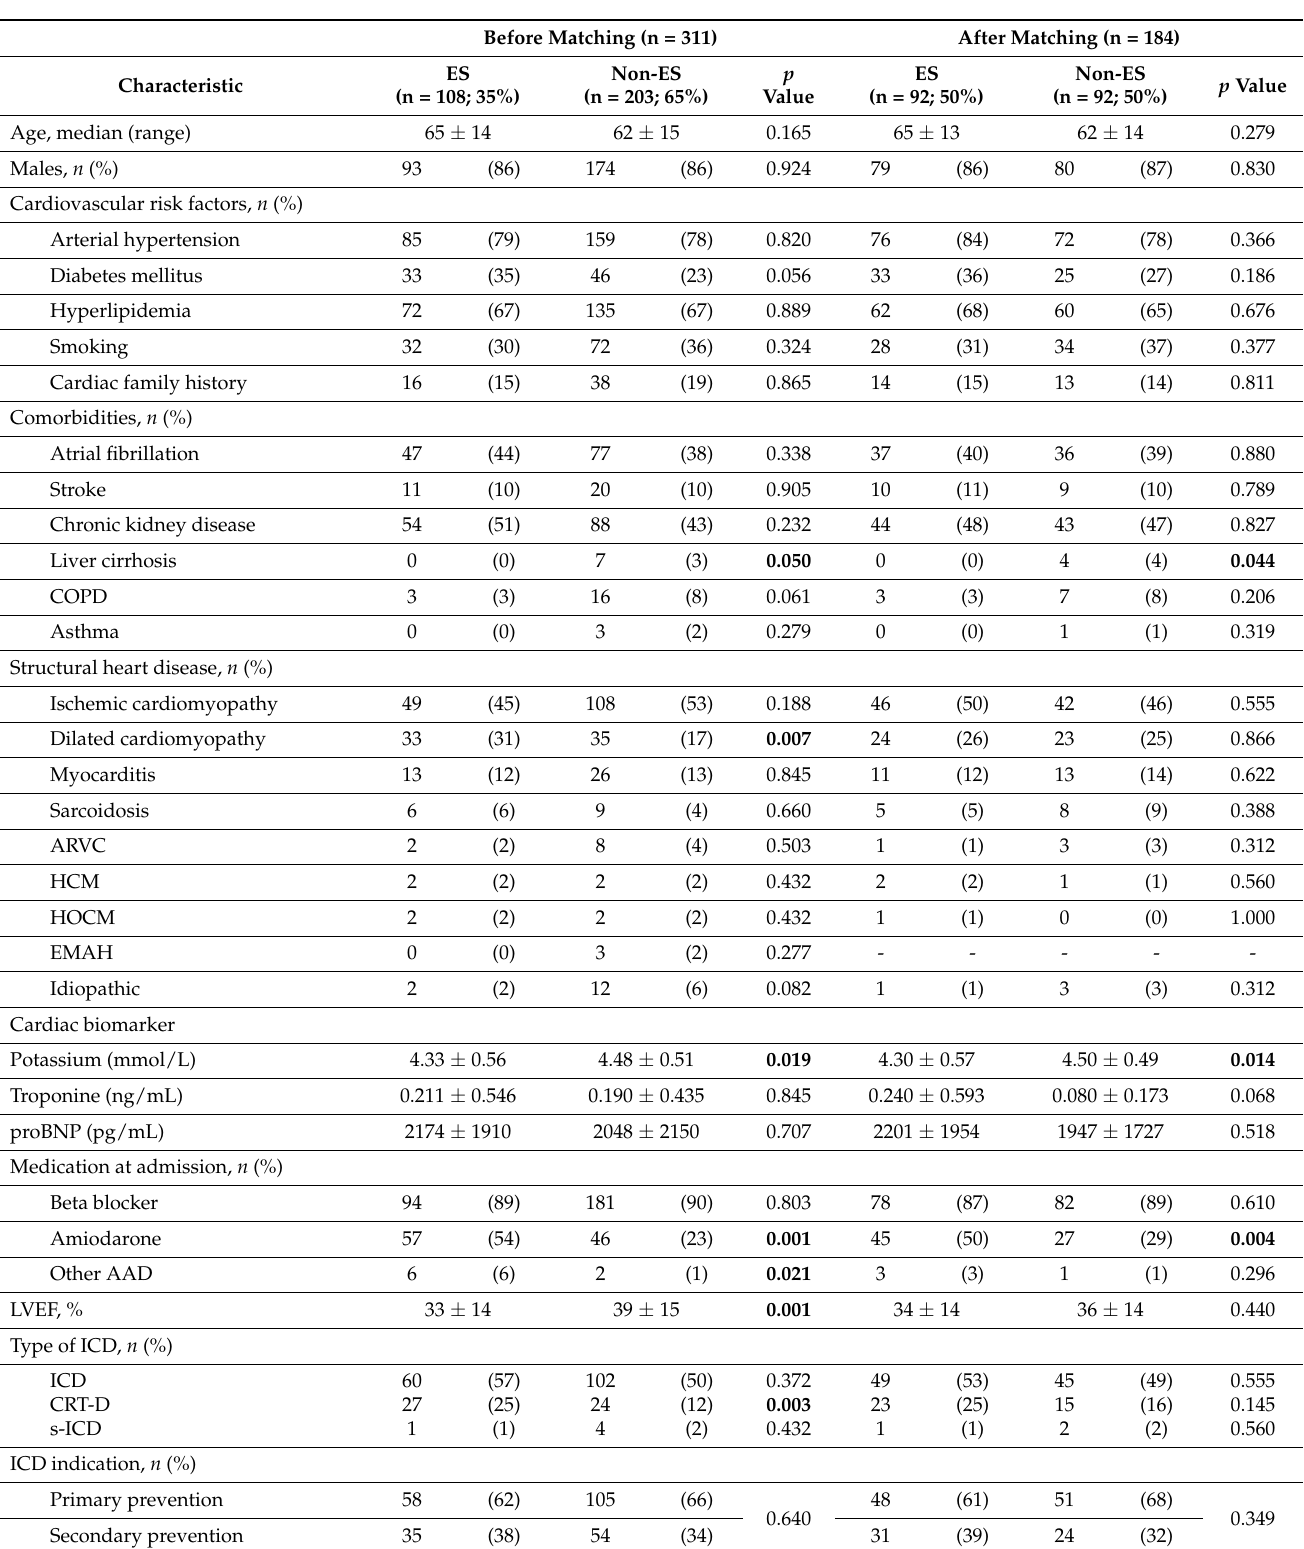
Table 1. Baseline